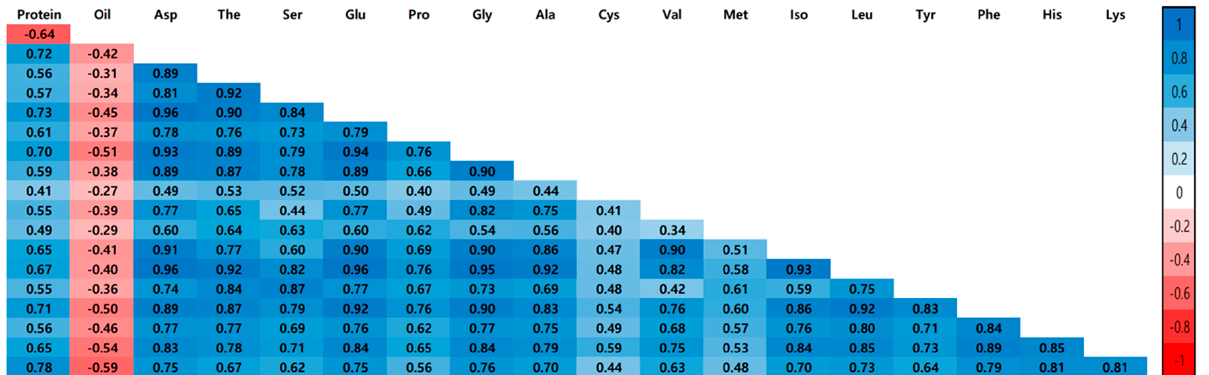
Figure 2. Distribution of protein and oil content in 203 wild soybean accessions. Asp, aspartic acid; Thr, threonine; Ser, serine; Glu, glutamic acid; Pro, proline; Gly, glycine; Ala, alanine; Cys, cysteine; Val, valine; Met, methionine; Iso, isoleucine; Leu, leucine; Tyr, tyrosine; Phe, phenylalanine; His,